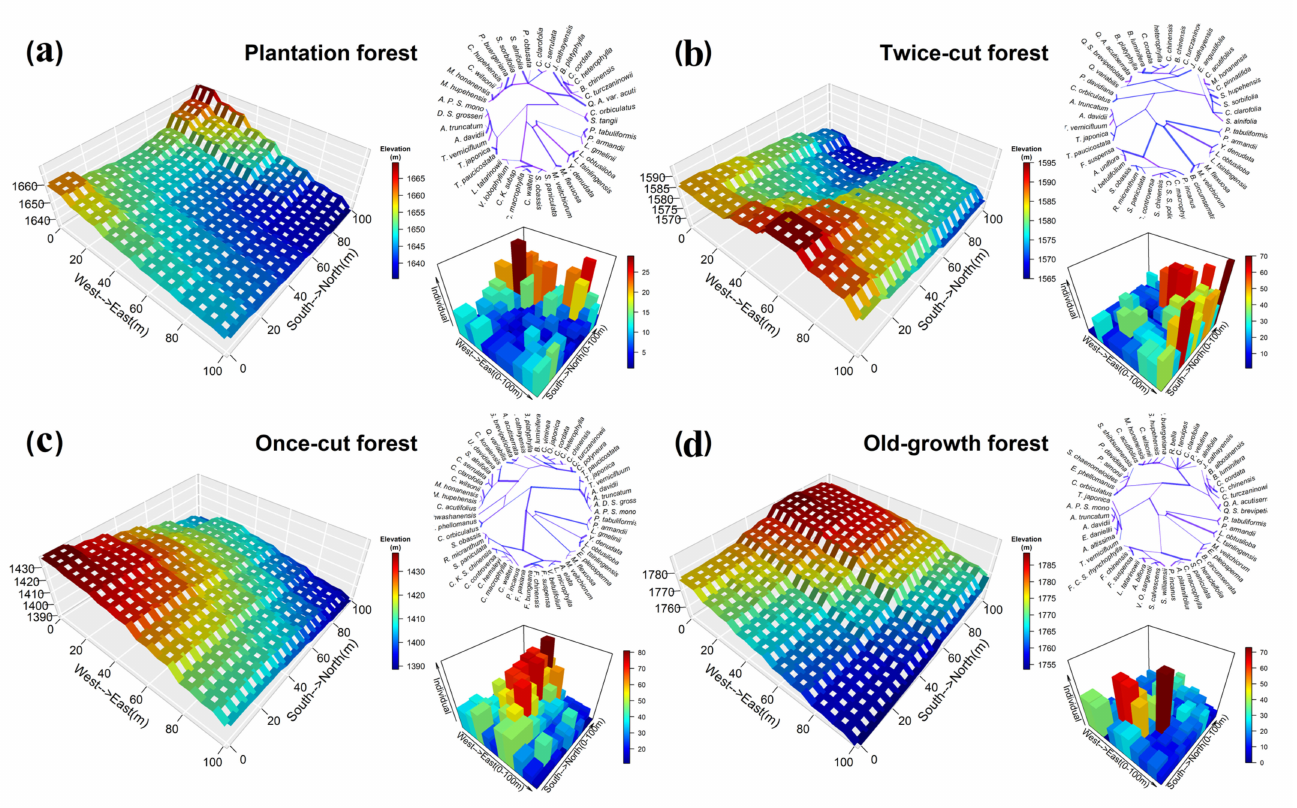
Figure 2. Topographic maps, phylogenetic trees, and spatial species abundances of woody plants in the plantation ( a ), twice-cut ( b ), once-cut ( c ), and old-growth ( d ) forests of the Baiyun Mountain Nature